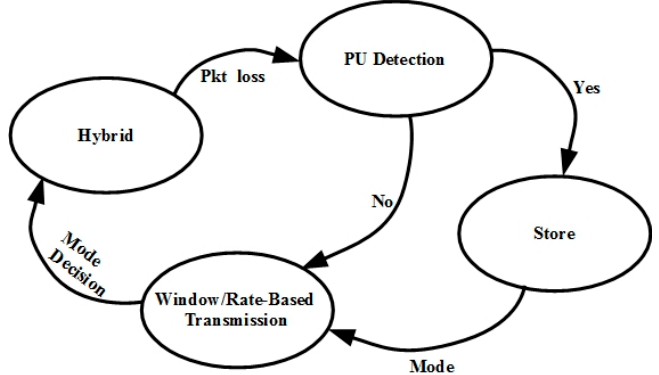
Figure 7. OHTP FSM. Figure 7. OHTP FSM.